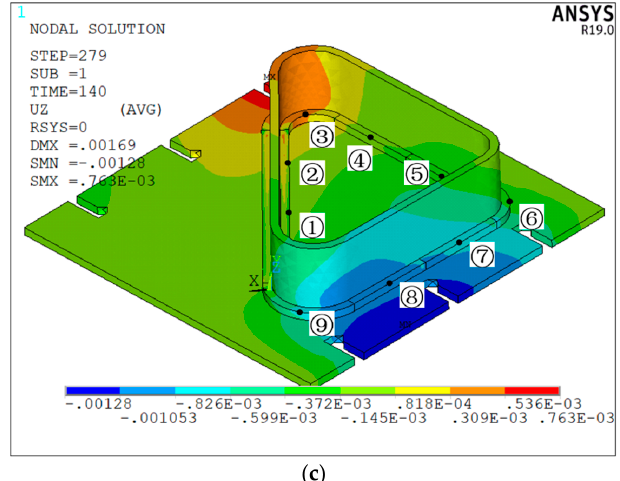
Figure 10. Deformation of welded structure 3 under the welding sequence of “ ⑤⑦④⑧②①③⑨⑥ ”: ( a ) total deformation cloud map; ( b ) deformation cloud map along the x -axis; ( c ) deformation cloud map along the z -axis. Figure 11 is the deformation cloud map of the welded structure 4 under the welding sequence of “ ①⑦③⑨②⑧④⑥⑤ ”. From Figure 11a, it can be seen that the deformation peak occurs in the middle of the bottom plate boundary. Among the three vertical plates, the deformation on the middle vertical plate is more serious, while the deformation on the left and right vertical plates is relatively small and relatively close. For the symmetrical welded structure, the optimized welding sequence adopts the method of symmetrically welding both sides of the vertical plate first, and then welding the middle vertical plate, which offsets the residual stress generated by the welding to the greatest extent and reduces the deformation. From Figure 11b,c, it can be seen that the difference between the transverse and longitudinal deformation peaks of structure 4 after double-sided welding is not very large, but there is a big difference in the peak position. The peak value of longitudinal deformation is larger than the peak value of transverse deformation, and the area where the peak value of longitudinal deformation occurs on the base metal is also larger than the area where the peak value of transverse deformation occurs. The peak of lateral deformation occurs on the vertical plate, and the peak of longitudinal deformation occurs on both the vertical plate and the bottom plate.